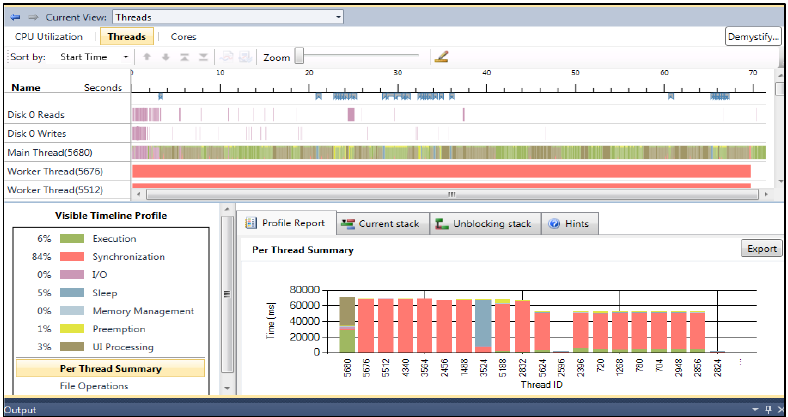
Figure 12. Allocation of the resources and the used threads for a usual work scenario.